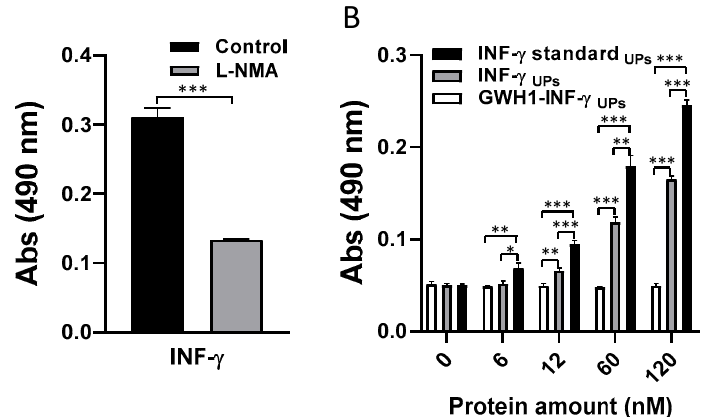
Figure 3. Nitric oxide (NO)-based bioassay for mouse IFN- γ activity evaluation in the murine microglial cell line BV-2. ( A ) Inhibitory effect of L-NMA (NG-monomethyl-L-arginine) on nitric oxide